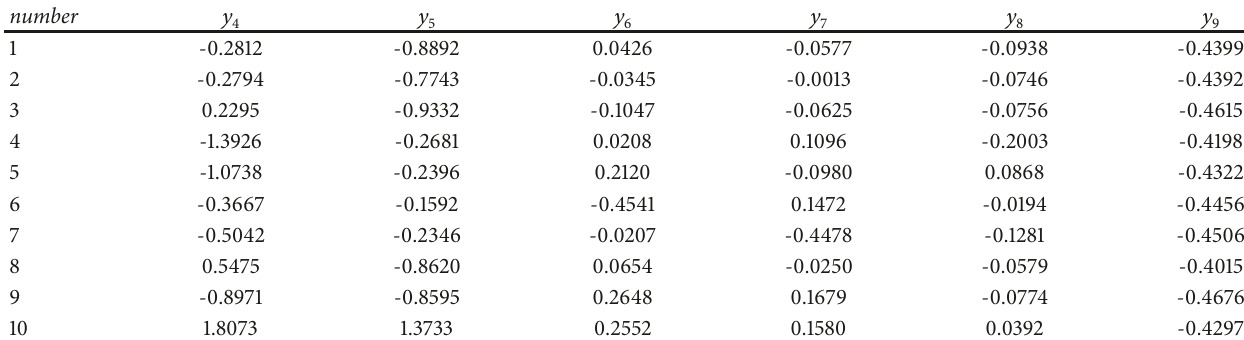
Table 5: The category feature of multiwavelet entropy of the normal growing condition